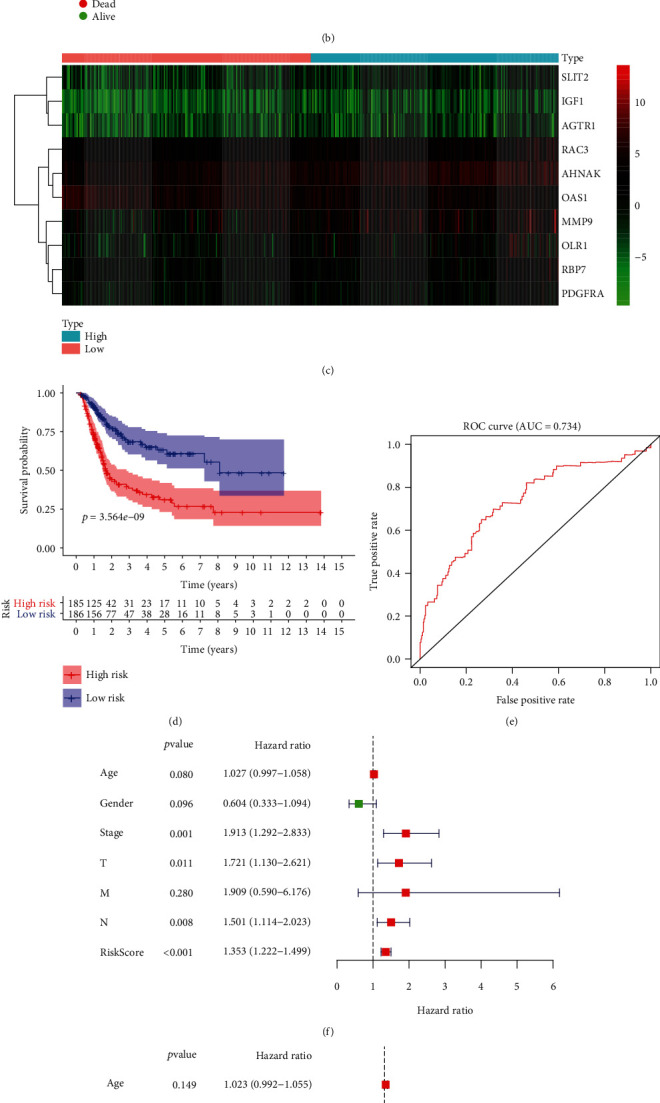
Heatmap of the signature consisting of 10 immune-related genes used to construct the immune-related risk signature for BLCA (a–c). The Kaplan–Meier survival analysis of the signature (d). ROC curve analysis of the signature (e). The Cox analysis of the signature and clinicopathological factors: the univariate Cox analysis (f); the multivariate Cox analysis (g).